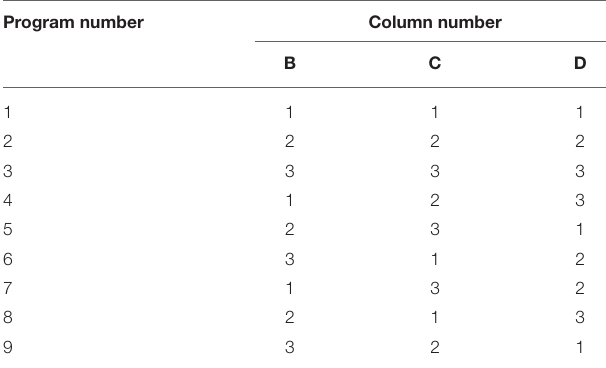
TABLE 2 | L 9 (3 3 ) orthogonal